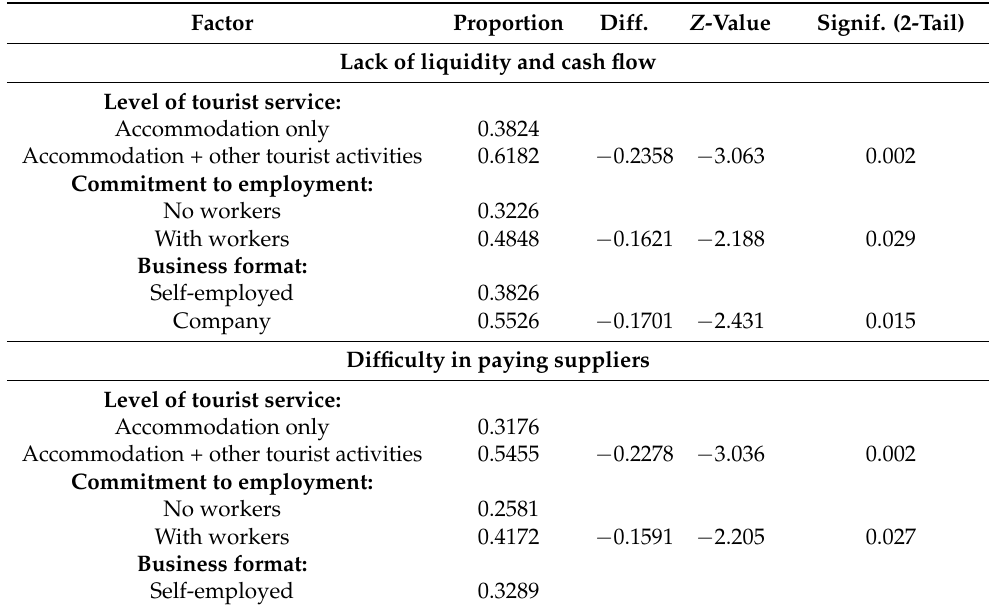
Table 3. Comparison of proportions of the effects of the COVID-19 lockdown on the tourism management of tourist accommodation A: economic-financial